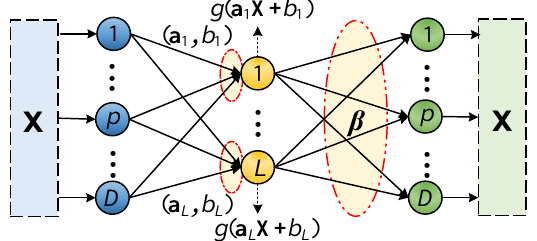
Figure 3. The structure of ELM-AE.